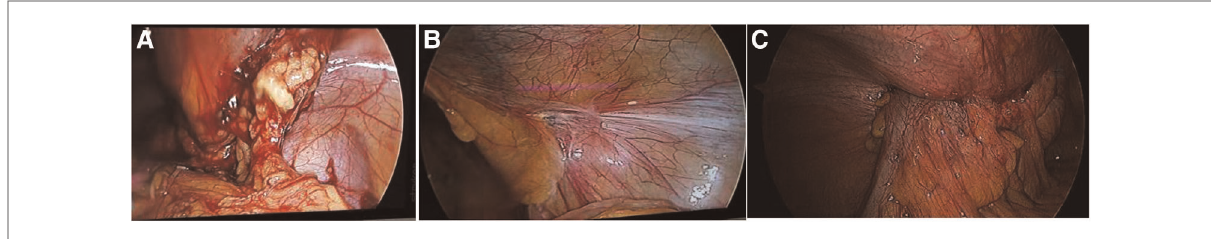
FIGURE 6 The mesh infection in laparoscopic exploration: ( A ) open preperitoneal hernioplasty showed adhesion of greater omentum; ( B ) lichtenstein repair showed no adhesion of inguinal region; ( C ) TAPP showed invasion of colon.